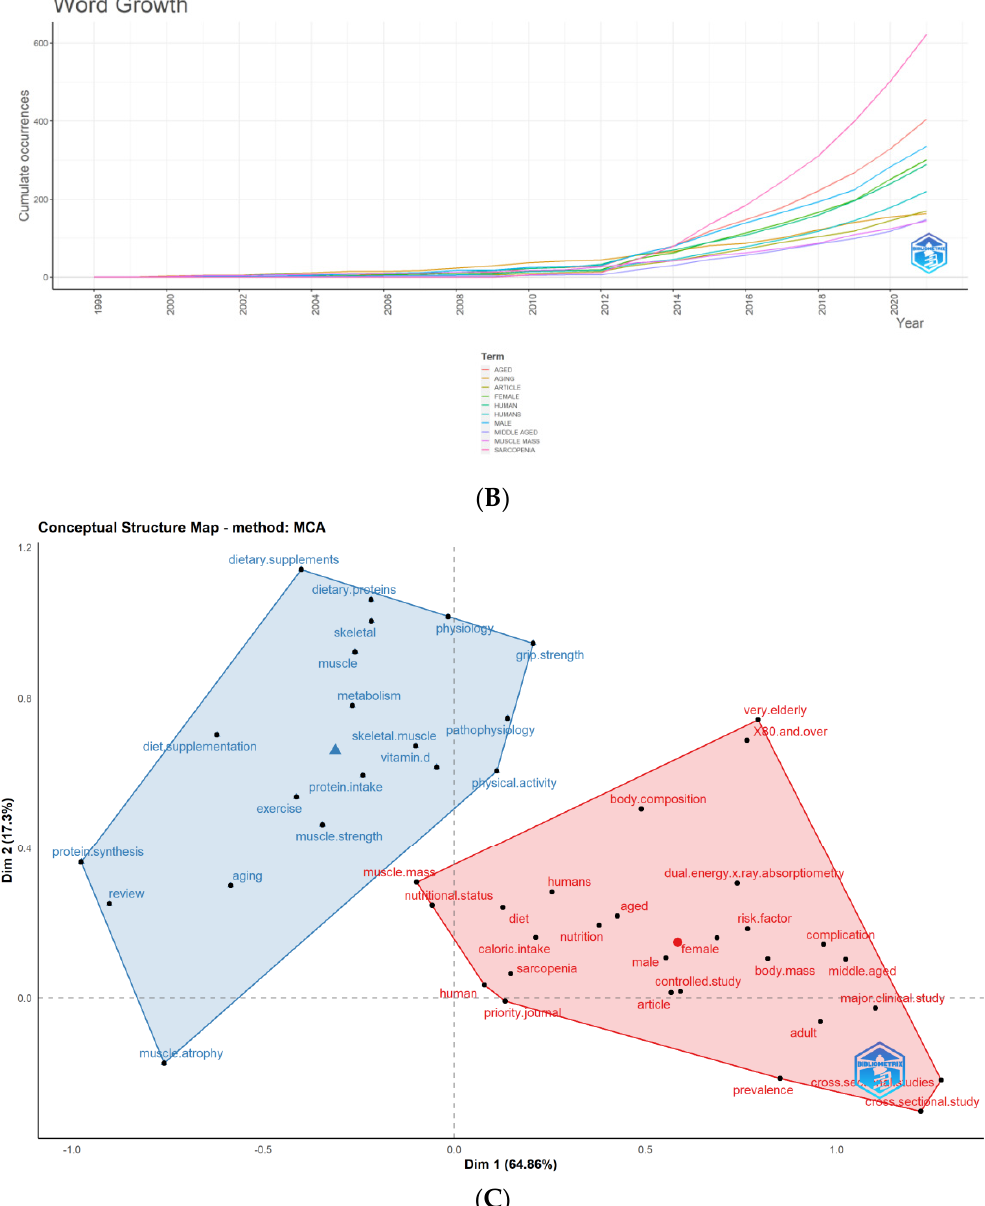
Figure 7. ( A ) The top 10 most relevant keywords in nutrition research for sarcopenia. ( B ) The top 10 most apparent trends in nutrition research for sarcopenia. ( C ) Nutrition research for sarcopenia conceptual structure map (map dimensions: average position of publications; map midpoint: centre of research area).